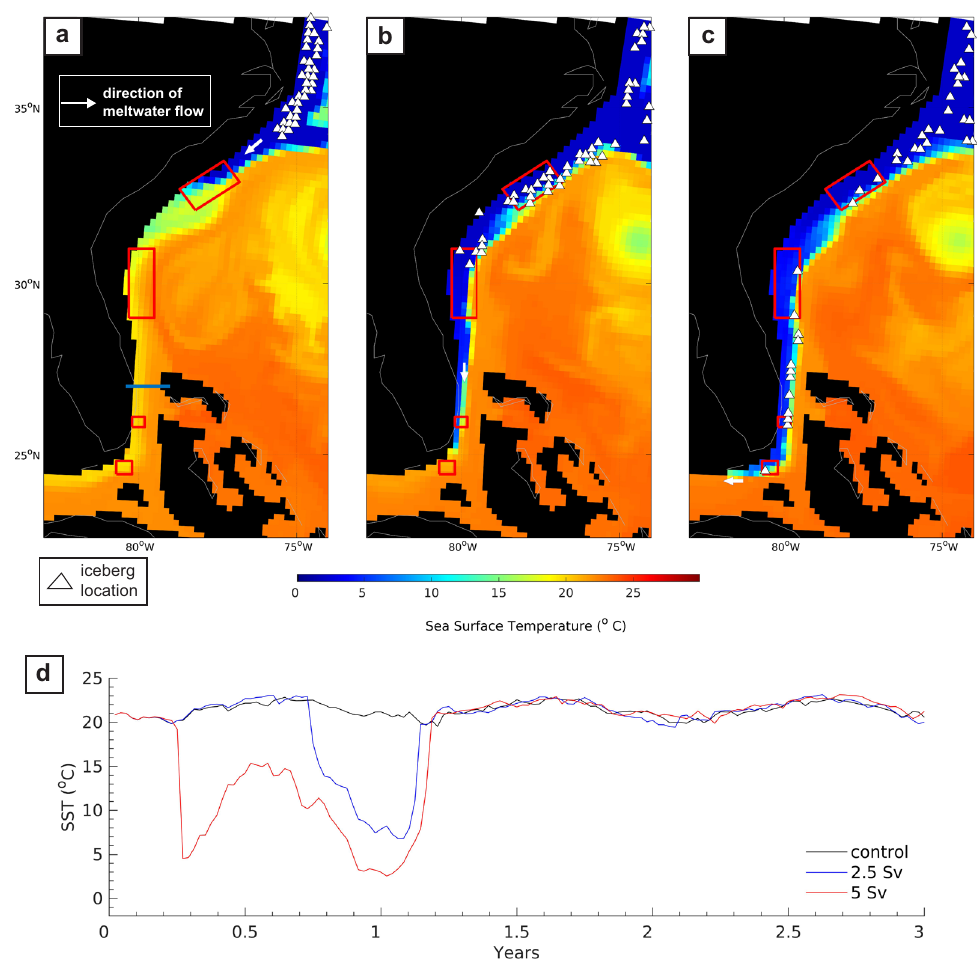
Fig. 8 Sea surface temperature in response to elevated meltwater discharge from Hudson Bay, Canada. Snapshots of sea surface temperature ( a – c ) 60, 75, and 90 days after a 5 Sv meltwater fl ood was released from Hudson Bay, Canada, and correspond to the same time periods shown in panels e – g of Fig. 7. The blue line at Florida Strait (in panel a ) highlights the cross section used to compile the time series of sea surface temperature show in panel d . Iceberg locations are denoted by the white